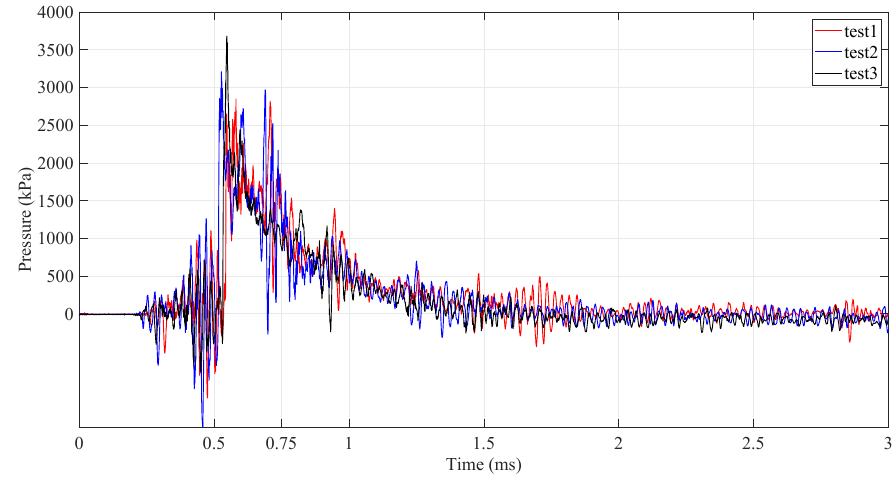
Figure 8. Pressure profile recorded by the high-frequency pressure sensor for the explosion of ( a ) 10 g, ( b ) 20 g, and ( c ) 30 g C4 charge masses.